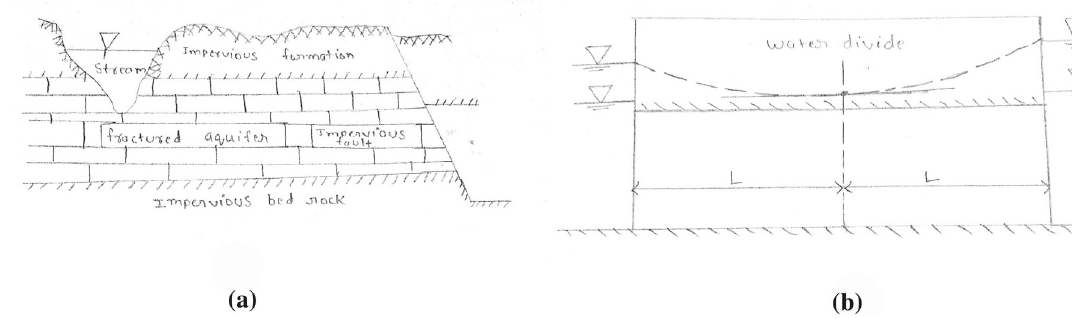
Fig. 1 The flow in fractured aquifer a real flow and b equivalent